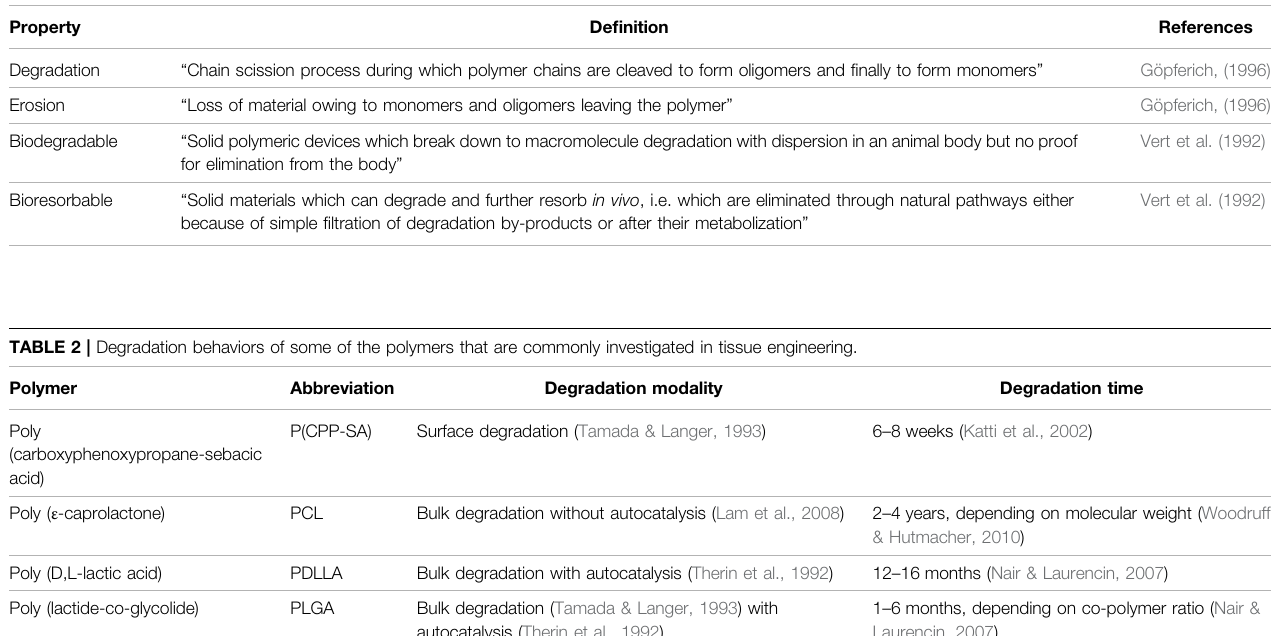
TABLE 1 | De fi nitions of degradation-related terms.